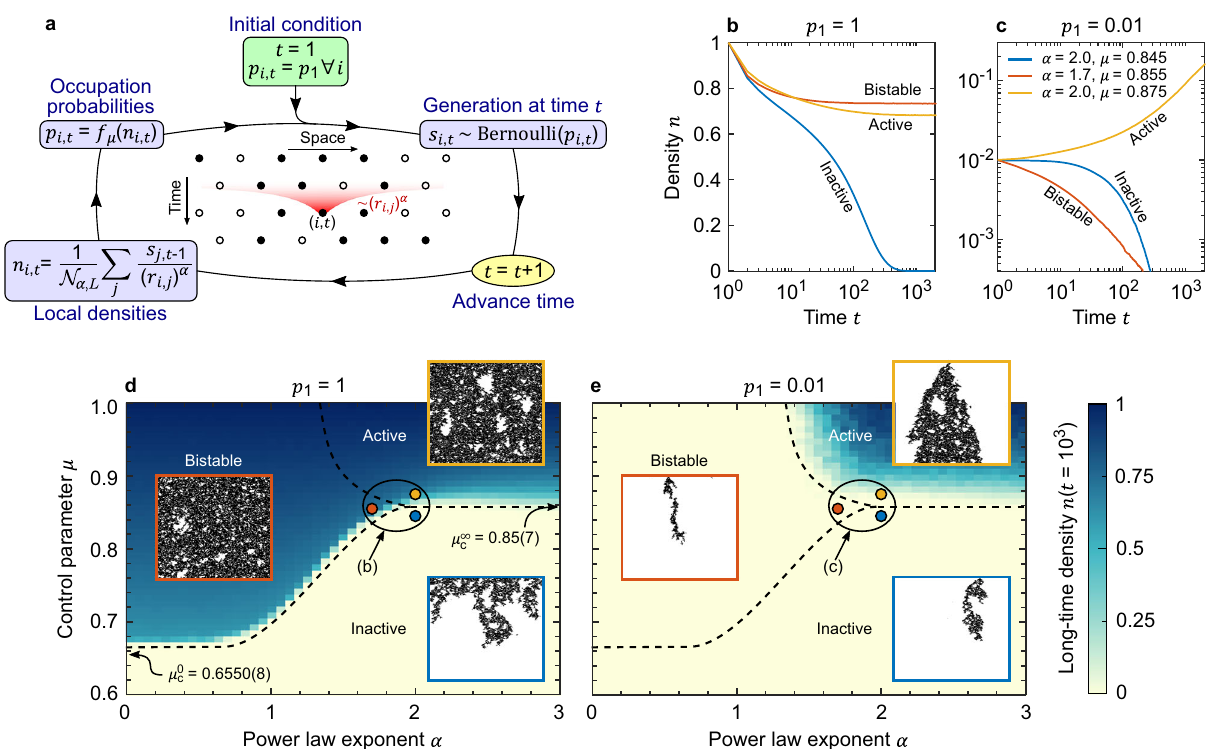
Fig. 2 Long-ranged directed percolation and bistability. a Flowchart representation of the long-ranged DP. Starting from an initial condition p i , t = 1 = p 1 , site i at time t is occupied ( s = 1) with probability p n – law-weighted averages of the previous generation f s (cid:2) (cid:3) i , t i , t . Local densities f i ; t g i are computed as power i ; t (cid:2) 1 g i , , see Eqs. (4) and (5). b , c Time evolution of the density n for p 1 = 1 ( b ) and p 1 = 0.01 ( c ) for and the occupation probabilities are updated as p i ; t ¼ f μ n i ; t various representative values of the power – law exponent α and control parameter μ . Three dynamical phases can be distinguished: (i) inactive — the density n decays to 0 (blue); (ii) active — n does not decay to 0 (yellow); (iii) bistable — n either decays to 0 or not depending on whether the initial density p 1 is small or large (red). d , e Long-time density n ( t = 10 3 ) in the plane of α and μ for p 1 = 1 ( d ) and p 1 = 0.01 ( e ). With the criterion used in b , c , we discern the three phases: inactive (light), active (dark), and bistable (light or dark depending on p 1 ). The dashed lines help locating the phases and coincide in d and e , and critical values μ 0 c and μ 1 c of μ in the limits α → 0 and α → ∞ , respectively, are reported (the offset of μ 0 c from the dashed line, as well as the softening of the dashed line for α ≈ 1, are due to fi nite-size effects). Crucially, the bistable phase is present only for small enough α ≾ 2, that is, for a suf fi ciently long- ranged DP. Single instances of the DP for the three phases are shown in the insets, as obtained for the α and μ indicated with coloured dots, and corresponding to the parameters used in b , c . Here R = 10 4 and 10 2 in b , c and d , e , respectively, and L =